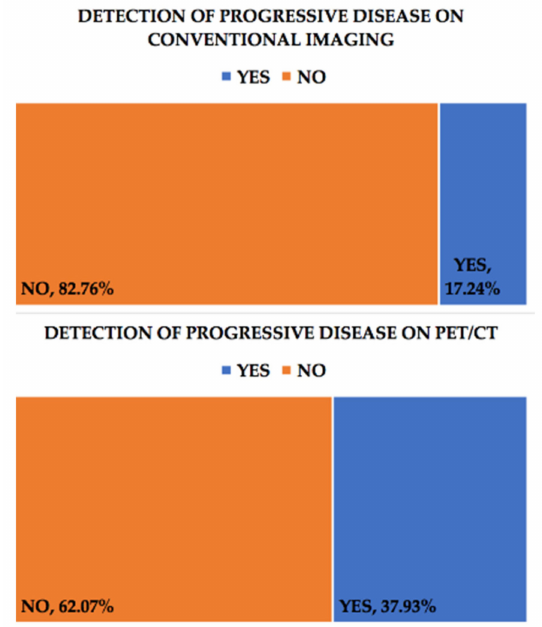
Figure 1. Progressive disease (PD) conventional imaging (upper chart) compared with F18-FDG PET-CT (lower